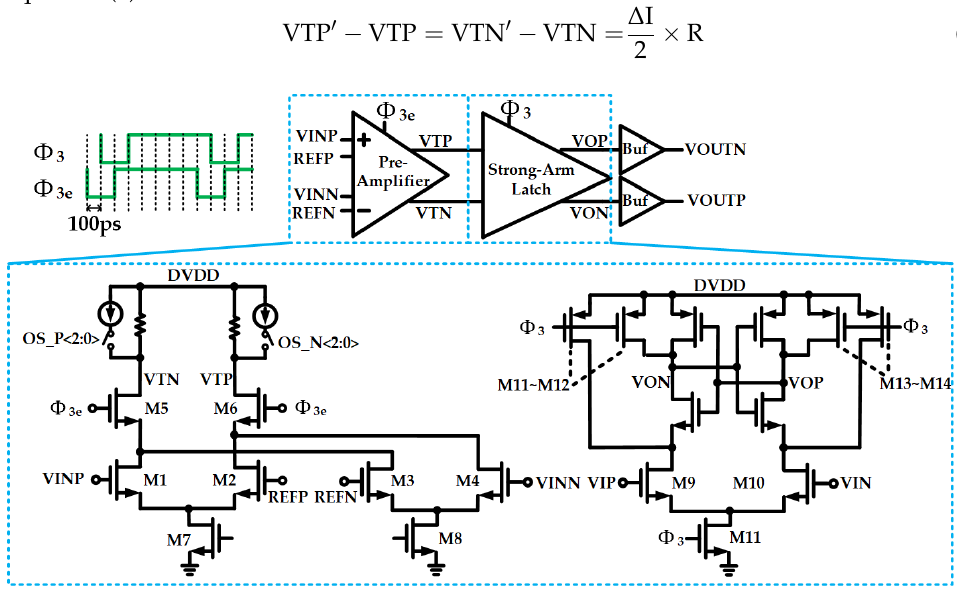
Figure 6. Comparator schematic, including pre-amplifier, strong- arm latch, and buffer. Ф 4 and Ф 4e are clocks for the designed comparators.